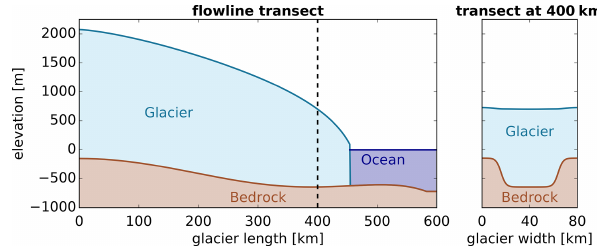
Figure 6. Set-up of the idealized glacier experiments. Only half of the set-up is shown; the glacier is connected to an identical copy on the left to ensure periodic boundary conditions at the ice divide.